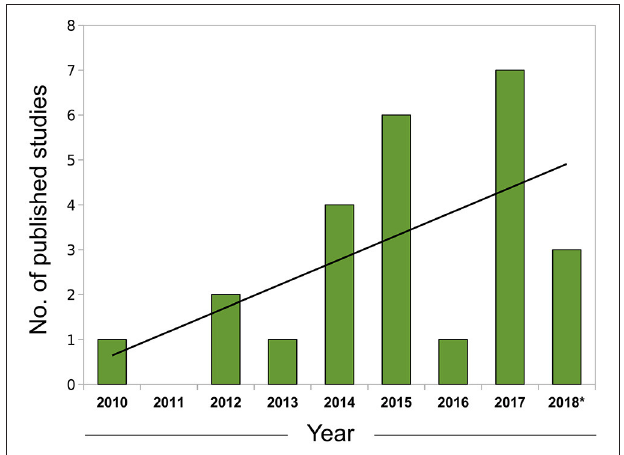
FIGURE 1 | Growth of leishmaniasis studies using RNA-seq indexed in PubMed (2010–2018). Search conducted in May, 2018 using the PubMed query builder with the following phrase: “leishmania*” AND (rna-seq OR rnaseq)—restricted to the Abstract or Title of papers. A linear trend line (black) was fitted to the data. *Data for 2018 comprehends Jan. to